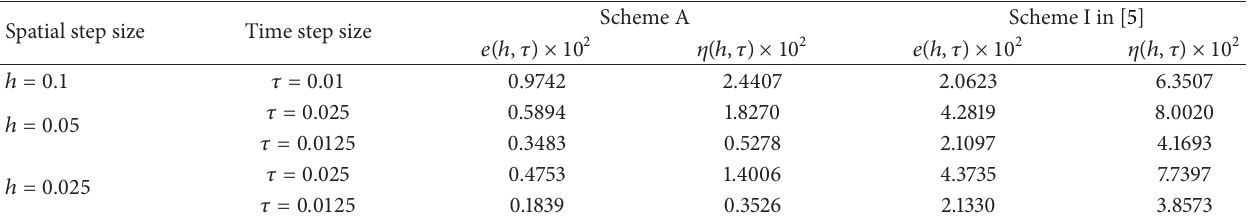
Table 4: Error comparison for Scheme B and Scheme I in [5] at time 𝑇 = 10